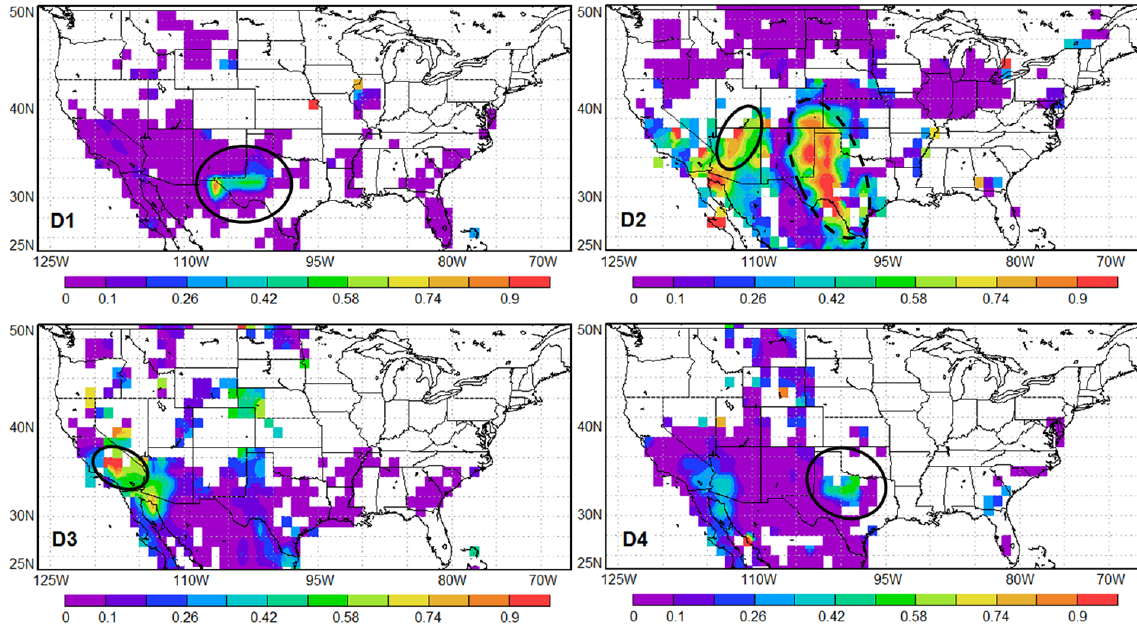
Figure 6. Mean aerosol optical depth over land using MODIS Deep Blue (550nm) data. The result is based on the level-3 products for the dust storm day (from the combined data set of Terra and Aqua). Regions circled by solid lines are dust storm regions. Regions circled by dashed lines are wildfire regions according to the wildfire record. (D1: 15 December 2003; D2: 5 July 2011; D3: 12 April 2007; D4: 24 February 2007.)